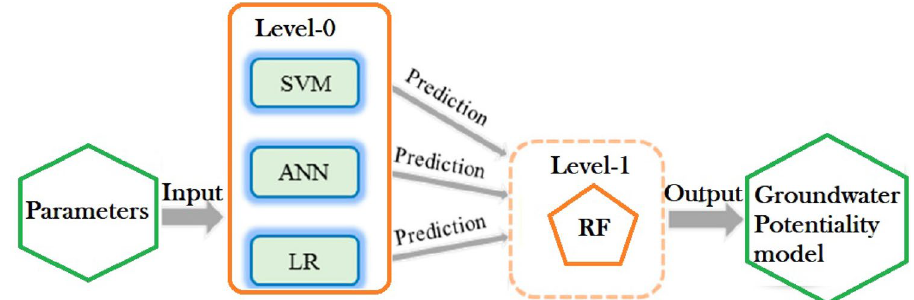
Fig. 5 Stacking-based ensemble frameworks for groundwater potentiality modeling. SVM support vector machine, ANN artificial neural network, LR logistic regression, RF random